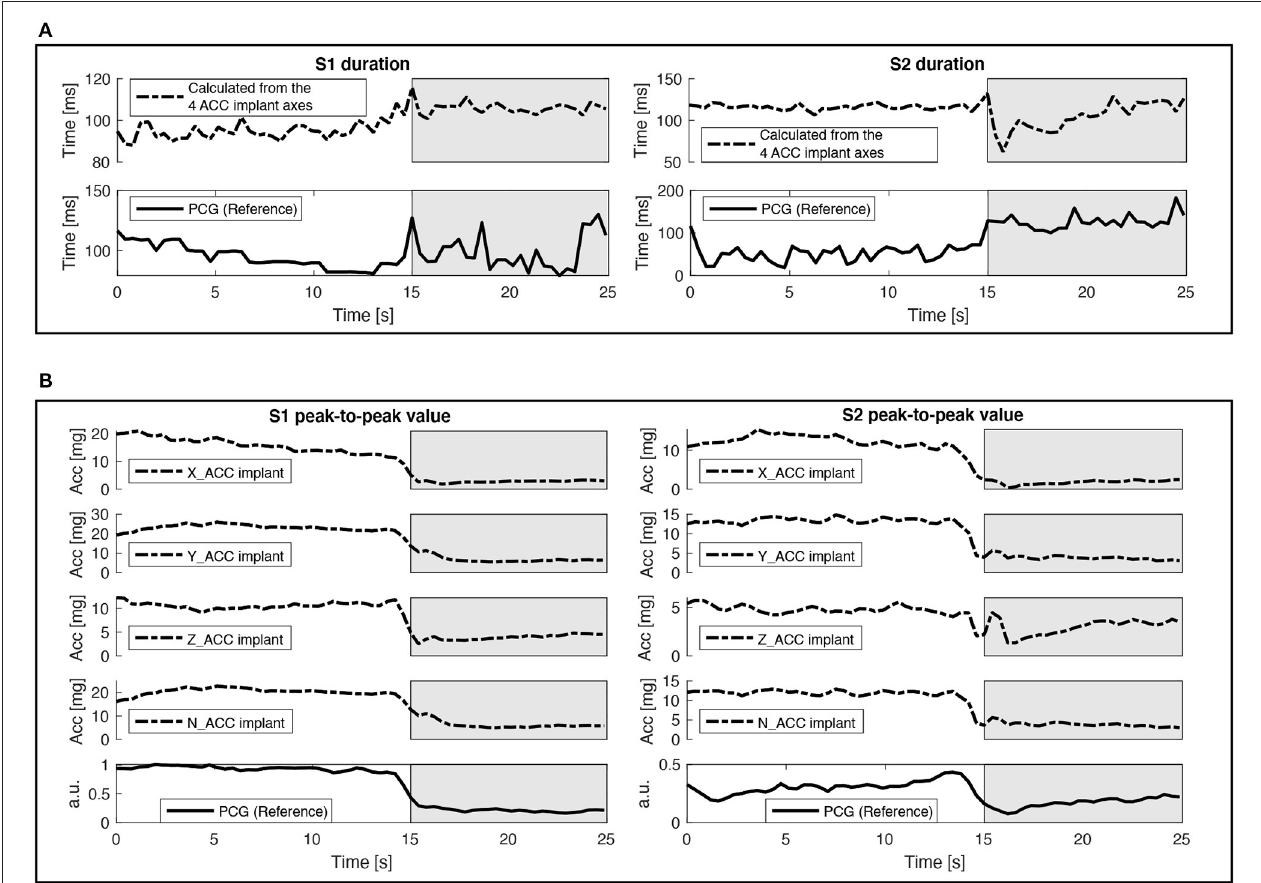
FIGURE 7 | Example of implant (ACC) and gold standard (PCG) signals evolution over time. Dash-dotted lines correspond to the implant signals and solid lines correspond to the gold standard reference signals. The white background corresponds to the CPP stage and the gray background corresponds to the apnea stage. (A) Time-profiles of the duration of S1 and S2 measured on the recording 1. (B) Time-profiles of the peak-to-peak values of S1 and S2 measured on the recording 1.